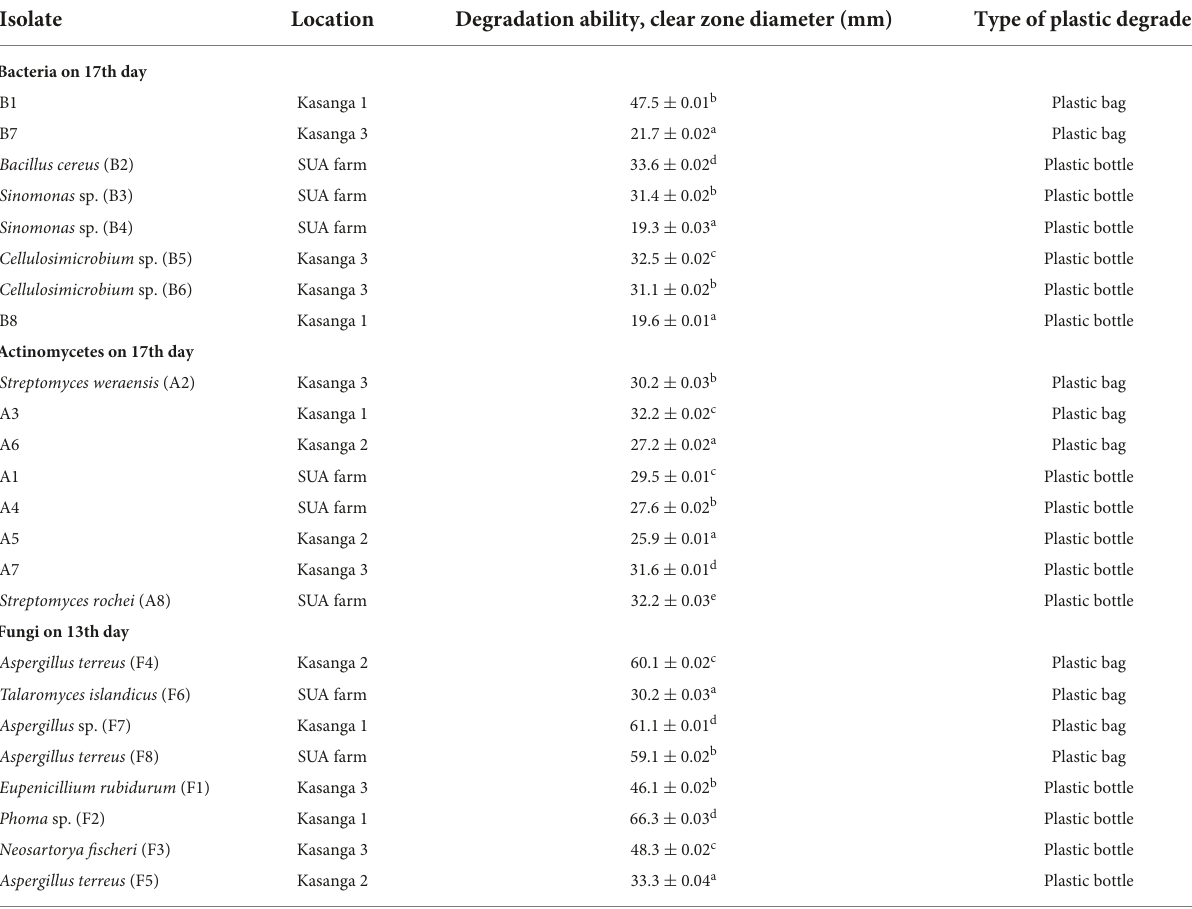
TABLE 8 Comparative efficiency of different bacteria, actinomycetes, and fungi in degrading polyethylene plastics bag and bottle on the 13th (fungi) and 17th days (bacteria and actinomycetes). Isolate